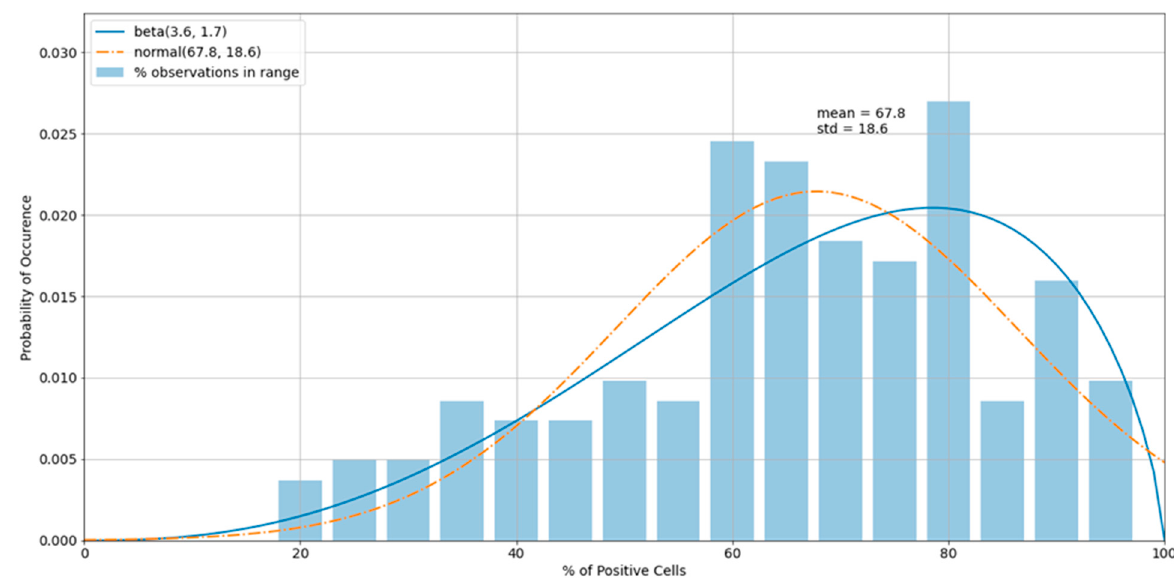
Figure 6. A histogram of the virus control observations (Figure 5) after outliers were removed. The histogram of the cell control observations (Figure 7) showed data that were heavily skewed toward 0%. Thus, outliers only on the right-hand side were checked. An estimated 95% boundary of beta (0.3, 7.2) or 19.0% was used as a cutoff interval for control outliers (Figure 8). The numbers were rounded to one decimal digit, which may have resulted in a slightly different cutoff value.